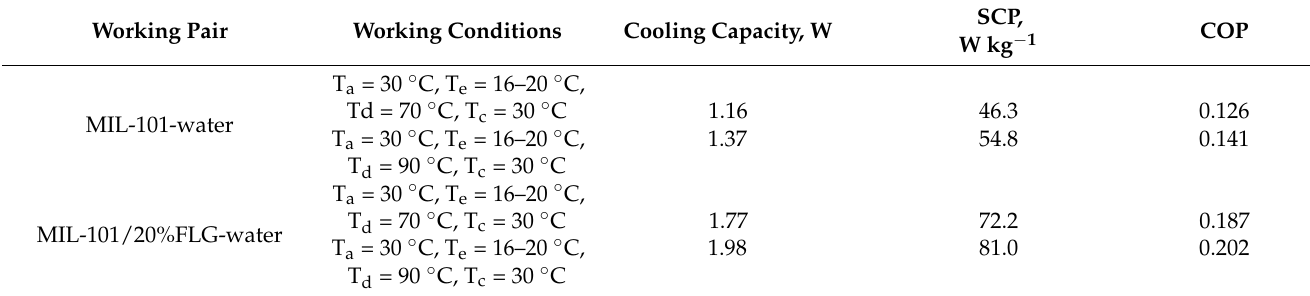
Table 1. Cooling capacity, SCP and COP of MIL-101-water and MIL-101/20%FLG-water working pairs for an adsorption water chiller application.